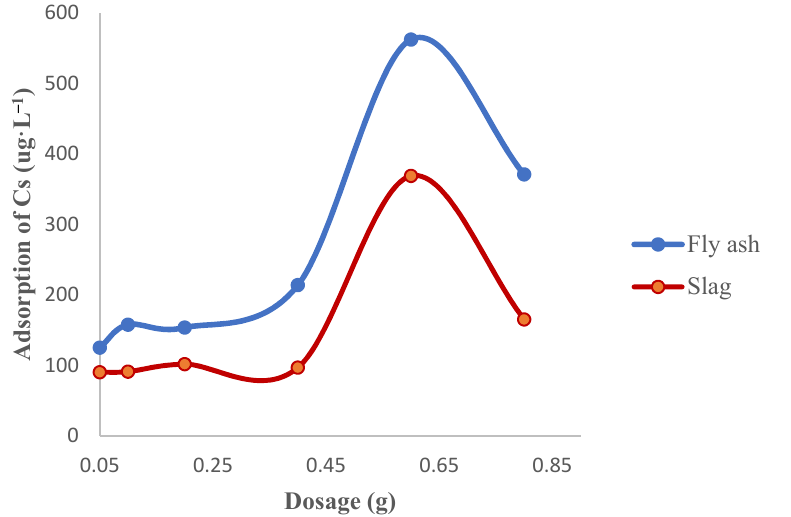
Figure 2. Effect of sorbent dosage on the adsorption of Cs by fly ash-based geomaterials and slag- based geomaterials.